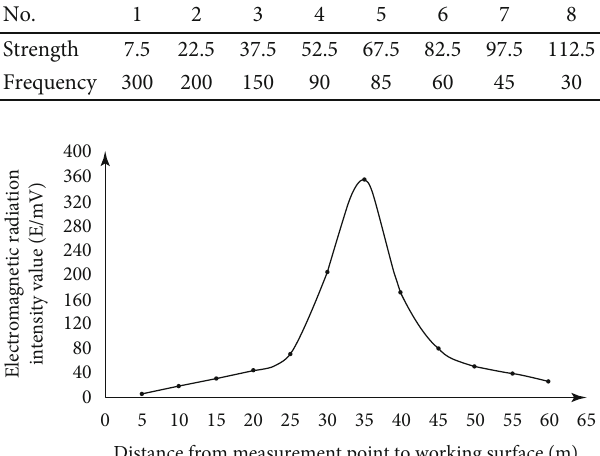
Figure 19: Curve of electromagnetic radiation monitoring value in the upper